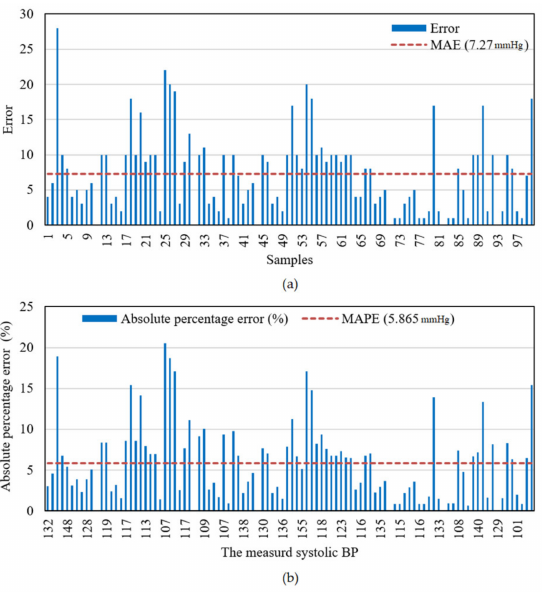
Figure 7. Error measurements of the systolic BP readings ( a ) an error with the number of samples ( b ) APE (%) relative to the systolic BM readings.